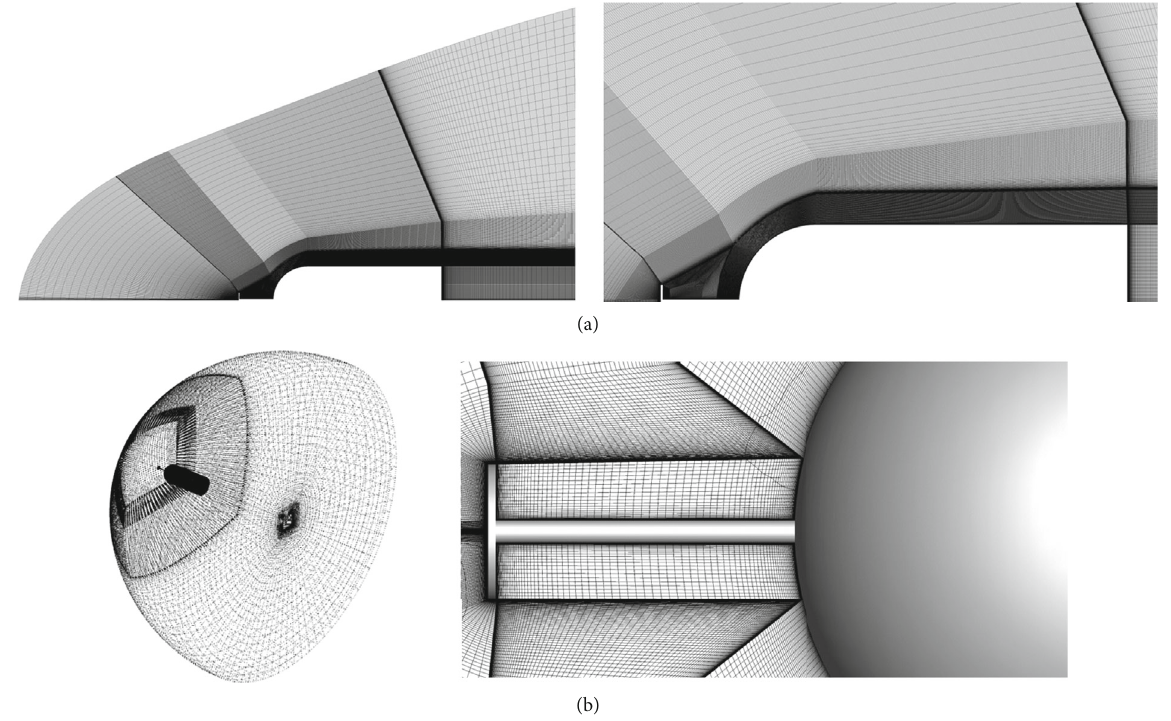
Figure 3: Computational mesh for the two cases. (a) two-dimensional and (b) three-dimensional.